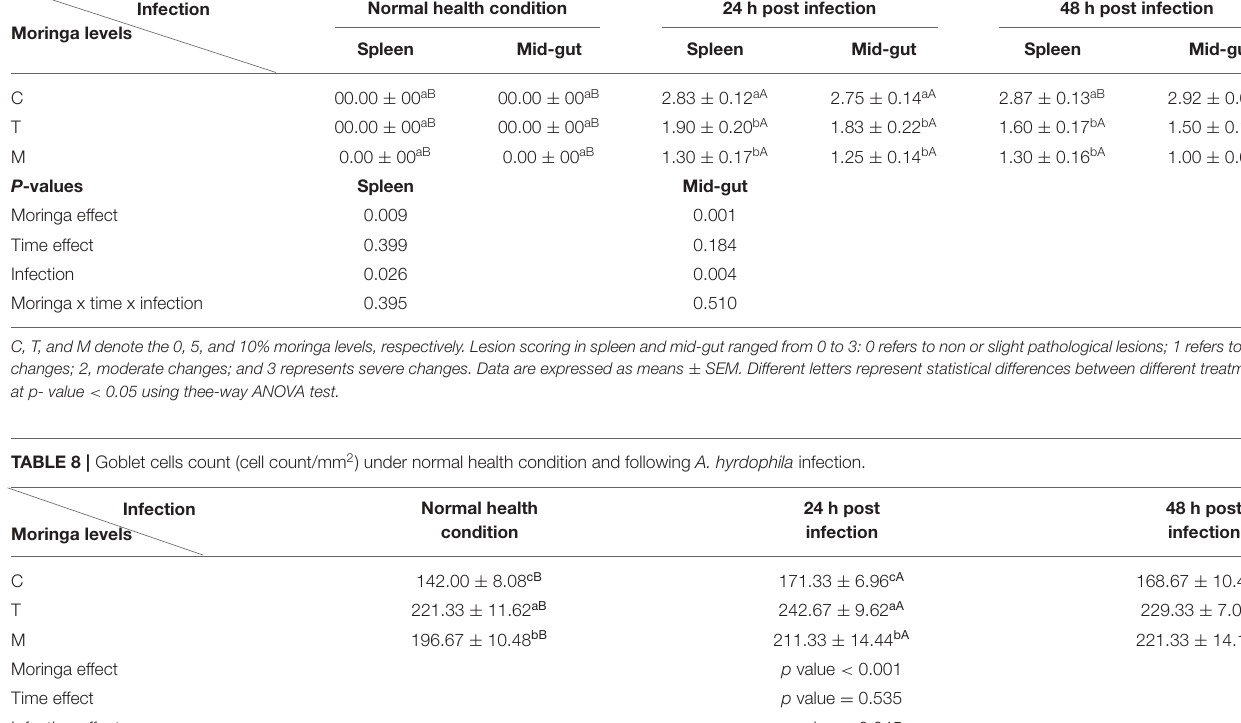
TABLE 7 | A summary of lesion scores in spleen and mid-gut of mono-sex Nile tilapia fed M. oleifera leaf powder containing diet. Infection Moringa levels